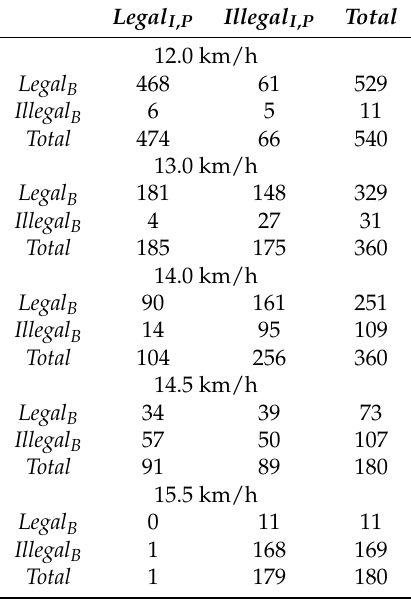
Table A2. Confusion matrix for the step binary classification of the proposed LOGC T , for tests at